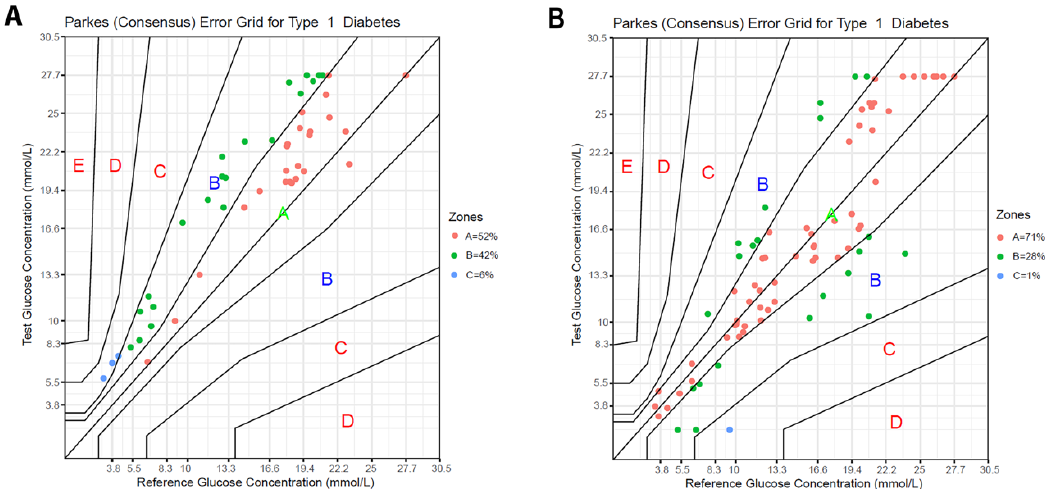
Figure 4. Parkes consensus error grid analysis (EGA) representation of the percentage of values within the different zones in ( A ) Group 1 and ( B ) Group 2 dogs. The reference glucose values (blood glucose obtained by a PBGM), on the x -axis, are plotted against the interstitial glucose (IG) measurements obtained by the FGMS, on the y -axis. The different zones designate the magnitude of risk: no effect on clinical action (zone A); altered clinical action—little or no effect on the clinical outcome (zone B); altered clinical action—likely to affect the clinical outcome (zone C); altered clinical action—could have a significant medical risk (zone D); and altered clinical action—could have dangerous consequences (zone E). ISO 15197:2013 requires that 99% of the values fall within zones A + B for a device to be considered accurate.